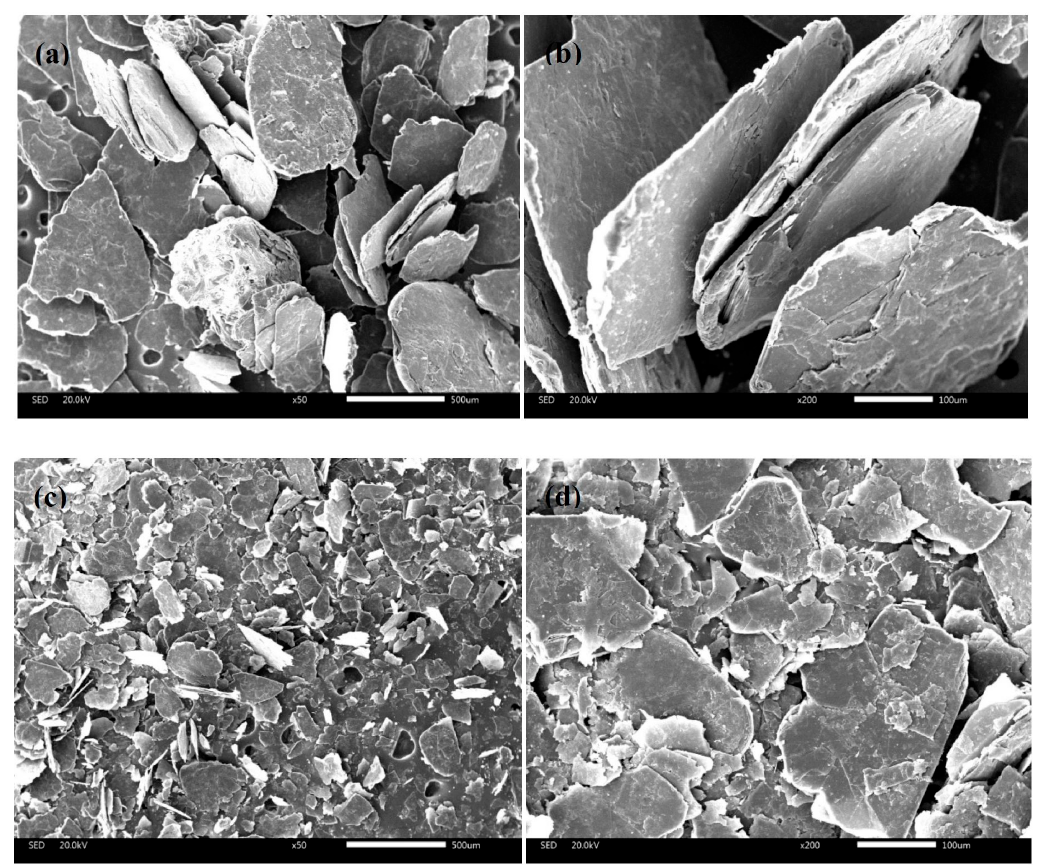
Figure 9. The SEM images of the final concentrate: ( a , b ) +180 µ m size fraction; ( c , d ) − 180 µ m size